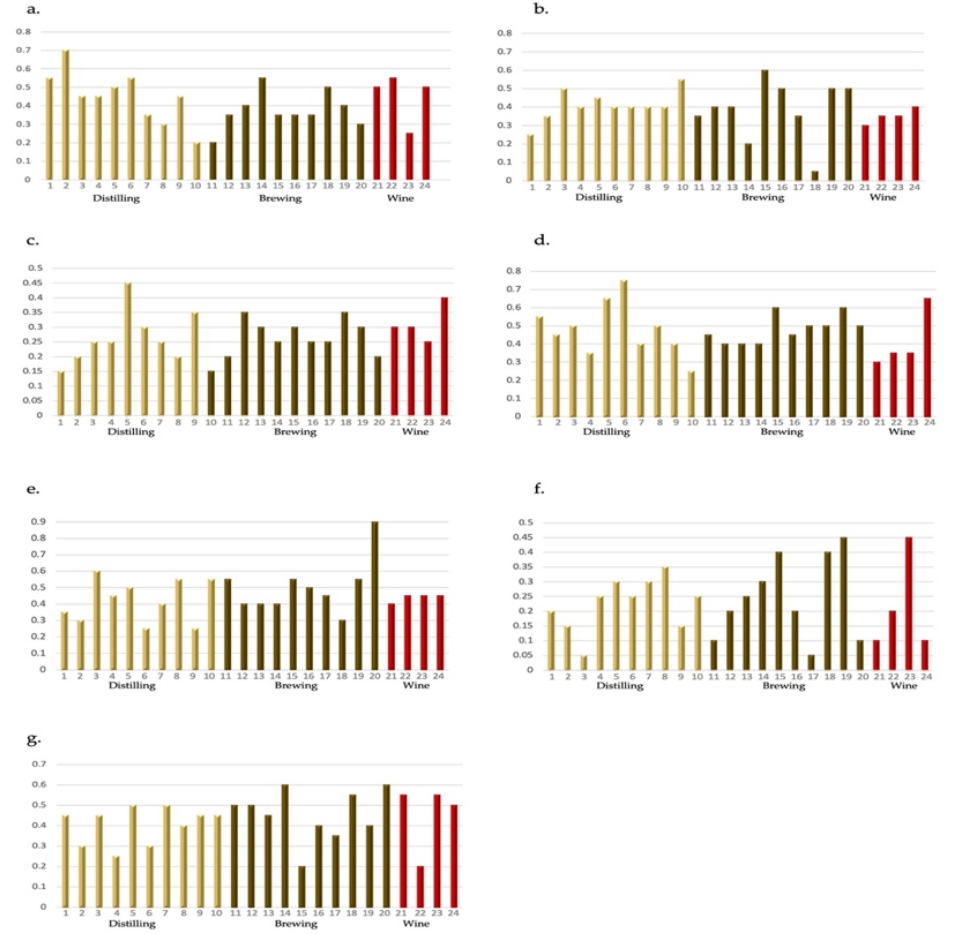
Figure 2. Average aroma intensity rating from 0 (absent) to 1.0 (most intense) for seven common aromas associated with whisky new make spirit: ( a ) Fruity (Fresh), ( b ) Fruity (Dried), ( c ) Floral, ( d ) Sweet, ( e ) Cereal, ( f ) Sulfury, ( g ) Feinty. Ratings are grouped by yeast type: Distilling, Brewing, or Wine; n =